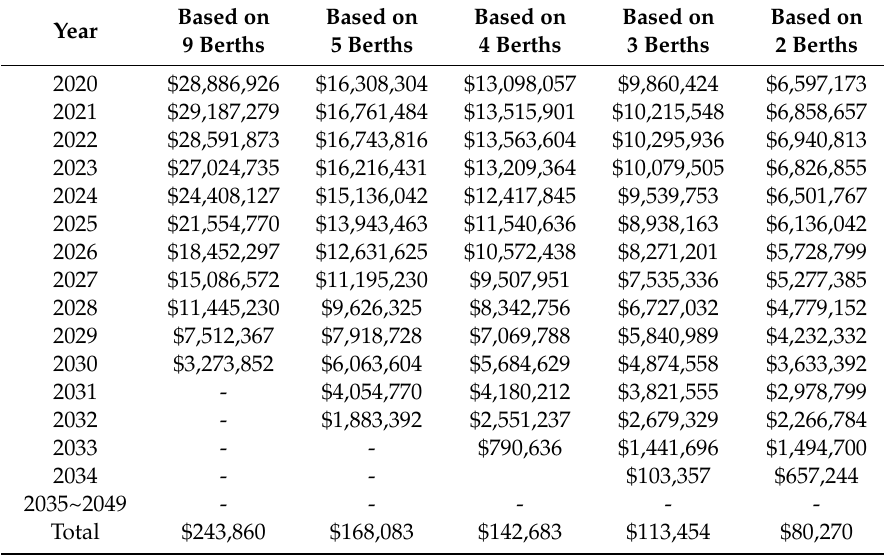
Table 9. Total interest costs per berths (unit: U.S. Dollars).